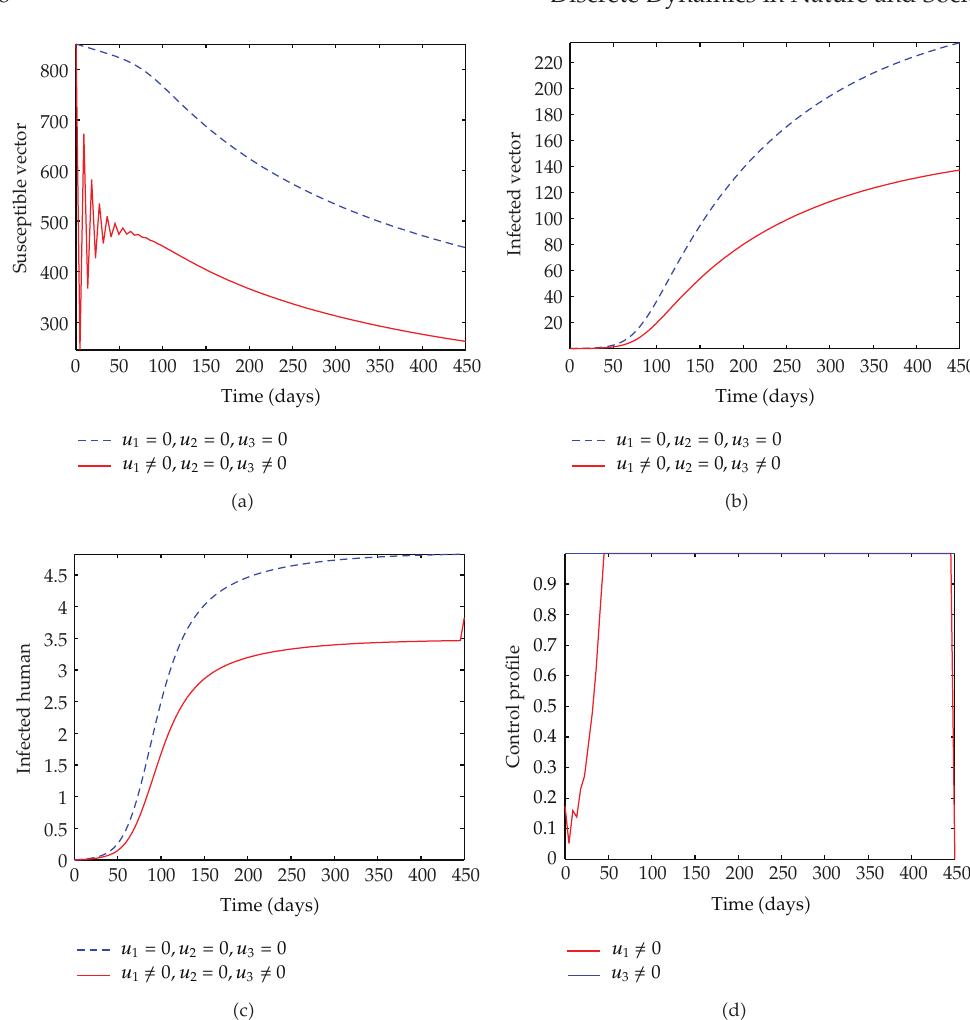
Figure 2: Simulations of the malaria model showing the e ff ect of control strategies on malaria transmission.